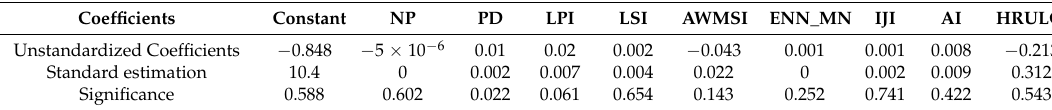
Table 11. The model significance table of